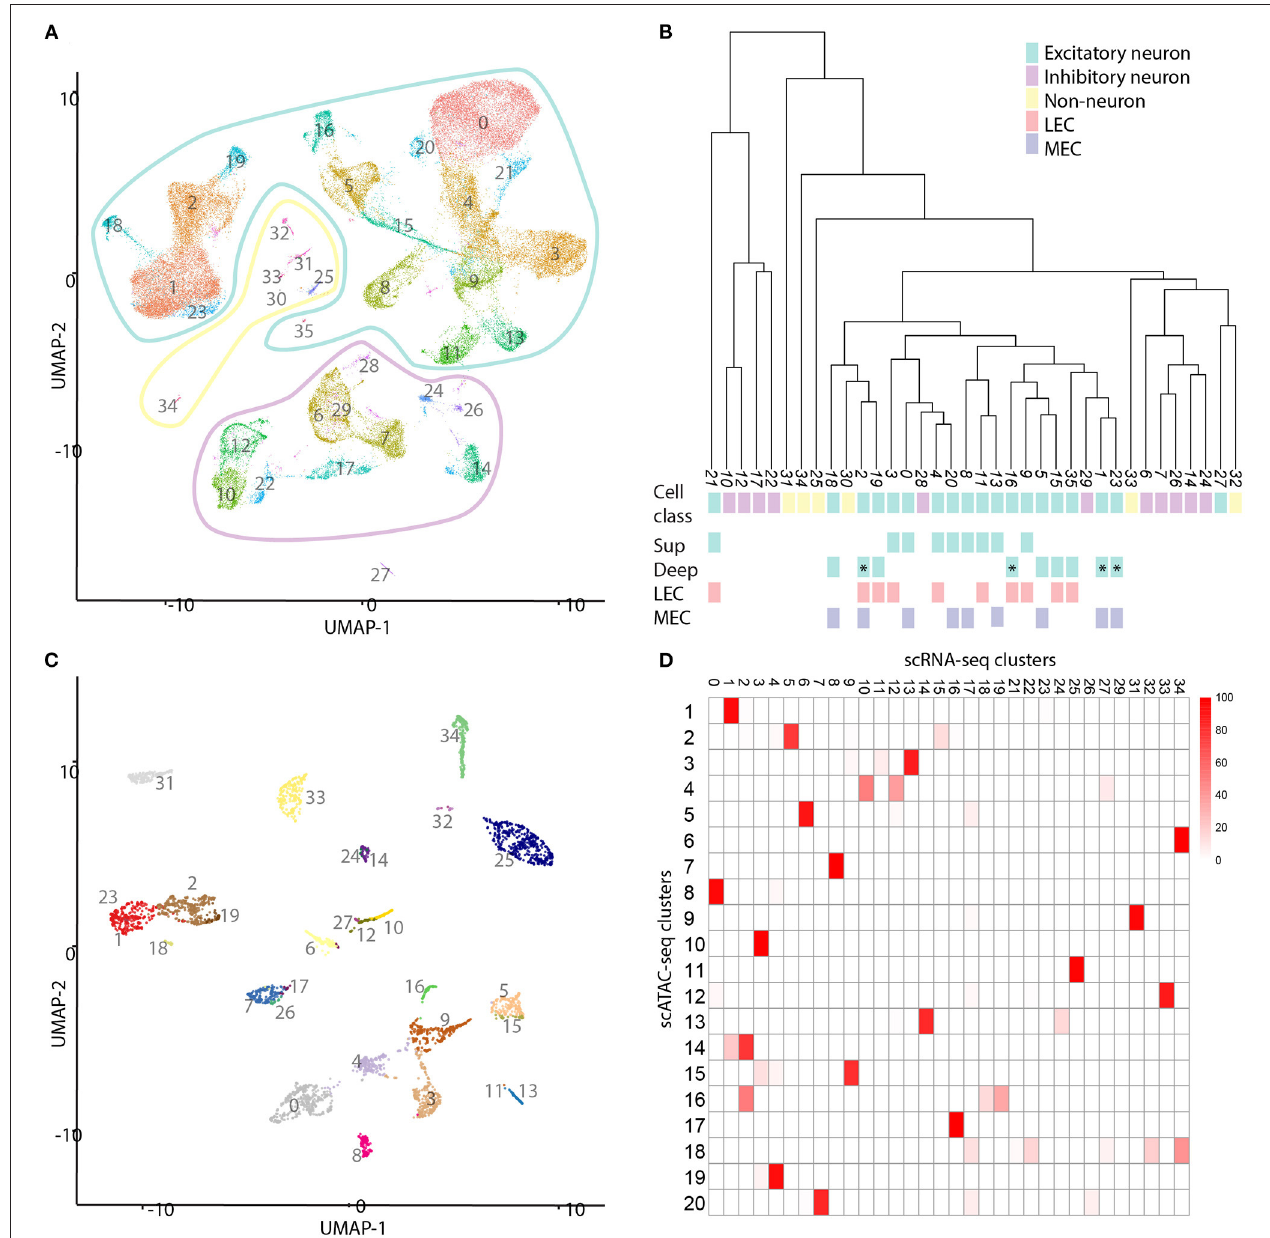
FIGURE 5 | Comparison of single cell transcriptomic and chromatin data. (A) UMAP projection of a selection of the cells published by Yao et al. (2021). We identified 36 different clusters of cell types in this subset of data. The outlines indicate three different classes of cells: non-neurons (yellow), inhibitory neurons (magenta), and excitatory neurons (cyan). (B) Hierarchical dendrogram of the clusters of scRNA-seq cells. Cluster numbers, cell class, and colors correspond with those in (A) . LVb clusters are indicated with an asterisk. (C) Projection of most similar transcriptomic cell types onto the scATAC data. Each transcriptomic cell is compared to each single cell ATAC cell and the connected to the most similar one. (D) Heatmap of mapping scATAC-seq on scRNA-seq cells. Each cell in the heatmap indicates the percentage of scATAC cells mapping to scRNAseq clusters. The scale bar indicates